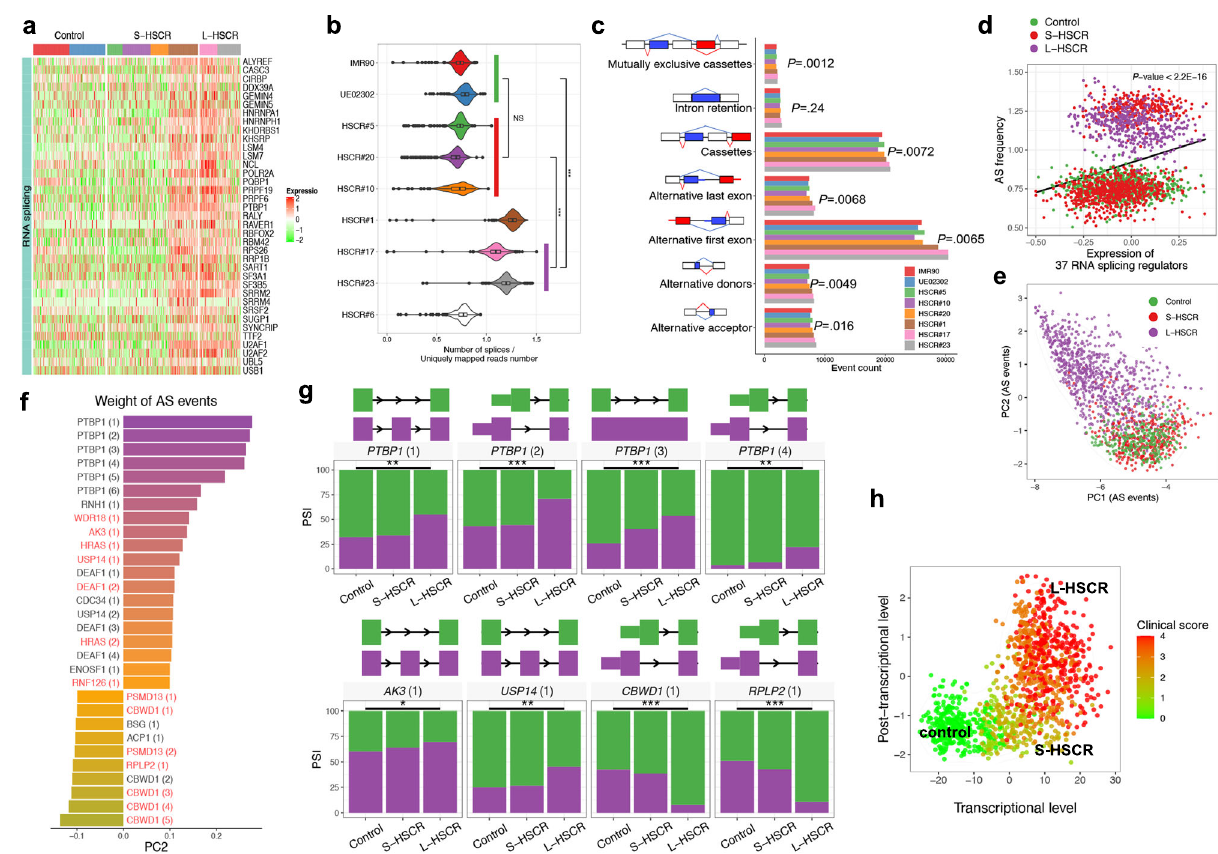
Fig. 4 | Global analysis of RNA alternative splicing (AS) events in control- and HSCR-ENCCs. a Heatmap shows the top 37 upregulated AS mediator genes enri- chedinHSCR#1andL-HSCR. b Normalizednumberofsplicesincontrol-andHSCR- ENCCs. P values (two-sided Mann – Whitney U -test)from comparing ENCCsderived from the two controls with 754 cells and various HSCR groups (three S-HSCR with 643cellsandtwoL-HSCRwith433cells)areshown.Thesplicingfrequencyofeach cell was estimated by the number of splices divided by the uniquely mapped read number. Tests marked by “ *** ” represent they are statistically different from the controls of P values <0.001. ns not signi fi cantly different. In the violin plot, each violin represents the kernel probability density of the data at different values. An inner boxplot indicates the interquartile range (IQR, the range between the 25th and 75th percentile) with the mid-point of the data. c Number ofdifferent types of RNA splicing events in control- and HSCR-ENCCs. ENCCs at high disease states (HSCR#1,17and23)werecomparedtothoseinlowdiseasestates(twocontrolsand three S-HSCR-ENCCs) ( P <0.05, two-sided t -test). d The 37 RNA-splicing regulator